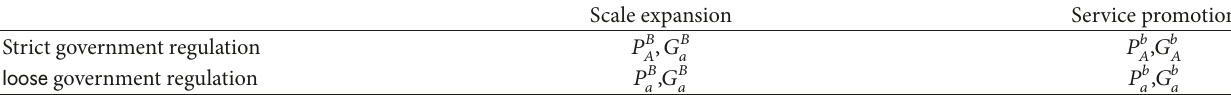
Table 2: Game return matrix between government and network